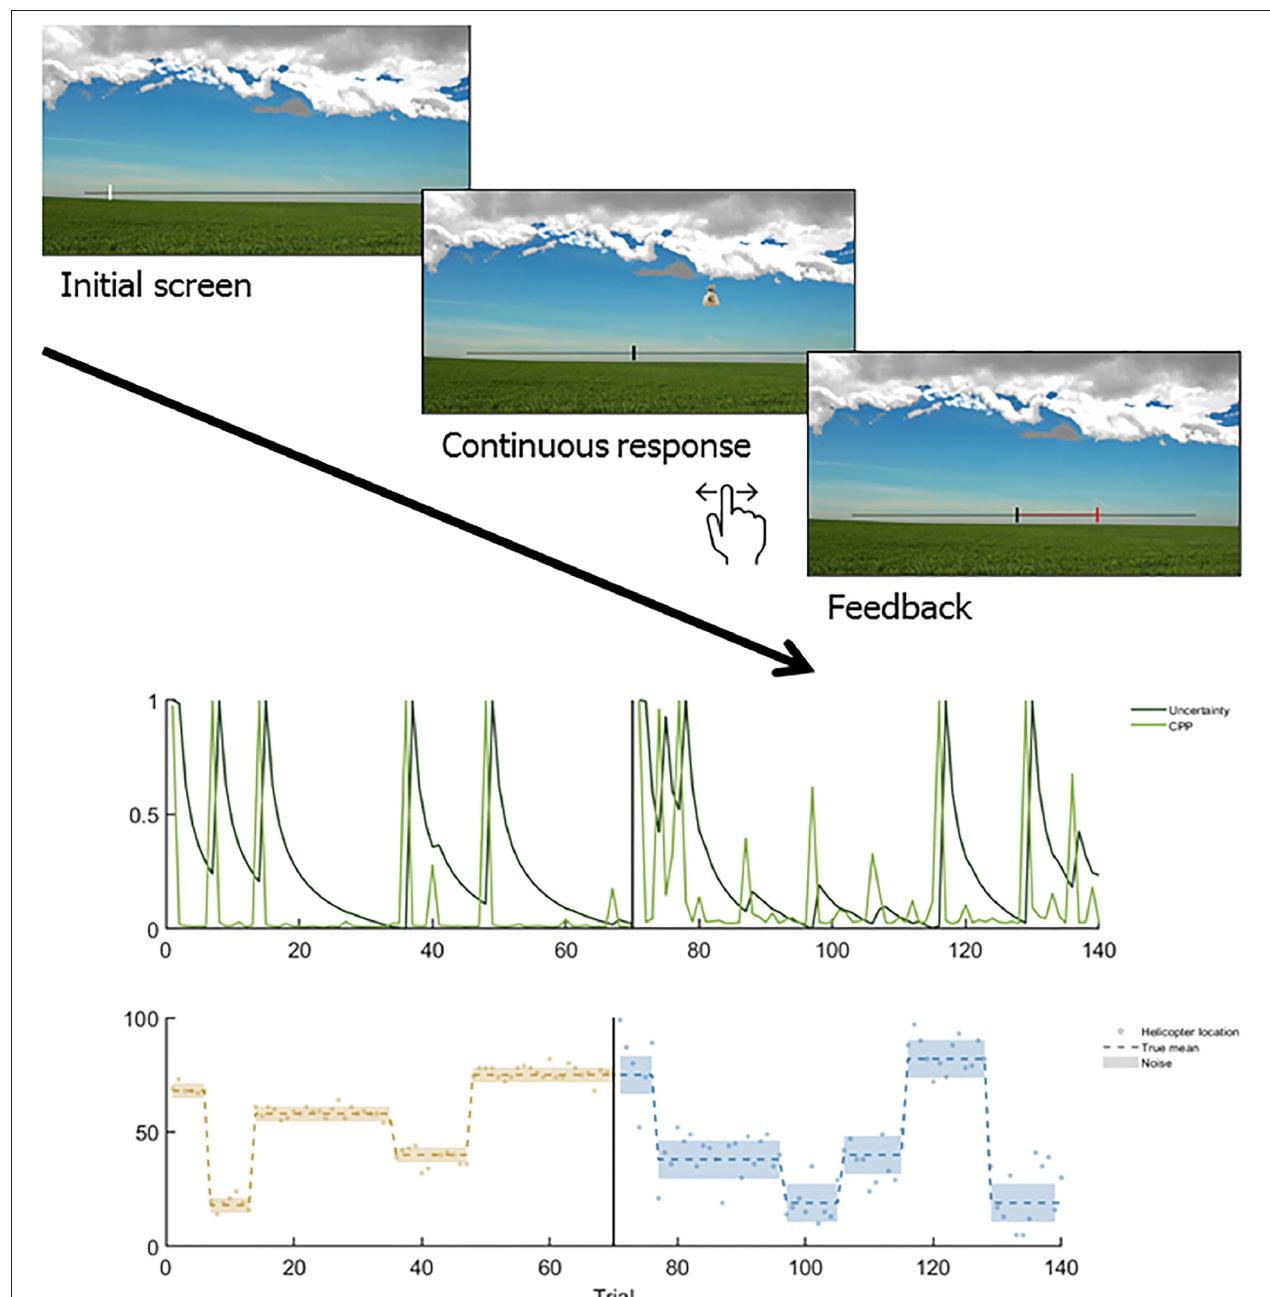
FIGURE 2 | Example of the Helicopter paradigm (12) and the associated CPD learning trajectories. Upper plot: Depiction of trial sequence in the helicopter task, in which a hidden helicopter moves horizontally and drops a bucket in each trial. Participants have to give a continuous prediction of the bucket location via joystick which is followed by feedback with a visualized prediction error (the distance between their prediction and the actual bucket location in red). Middle plot: Light green represents the optimal trajectory of change-point probability and dark green represents the optimal trajectory of change-point probability (CPP) over the course of 140 trials. Lower plot: Dots represent the helicopter’s locations, dispersing around the true mean (dashed line) in the low noise block (light brown) and the high noise block (light blue). Y-axis corresponds to the horizontal scale in the upper part.